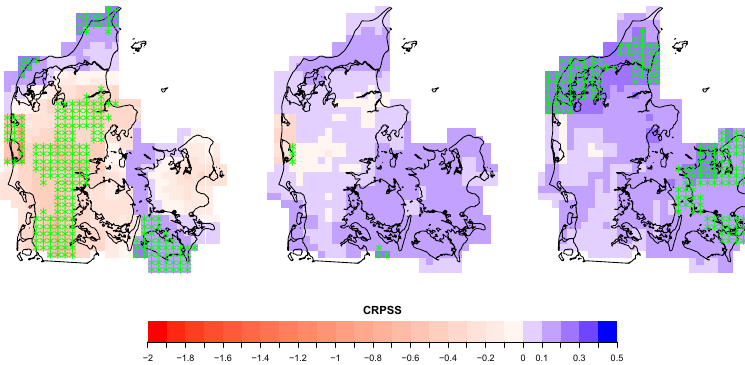
Figure 6. Spatial variability of skill in accuracy for summer (JJA) raw forecasts for a lead time of 1 month. The grids marked with “ ∗ ” are points where the distribution of the accuracy for ensemble climatology differs from the accuracy distribution of the ECMWF System 4 forecasts at a 5% significance using the WMW